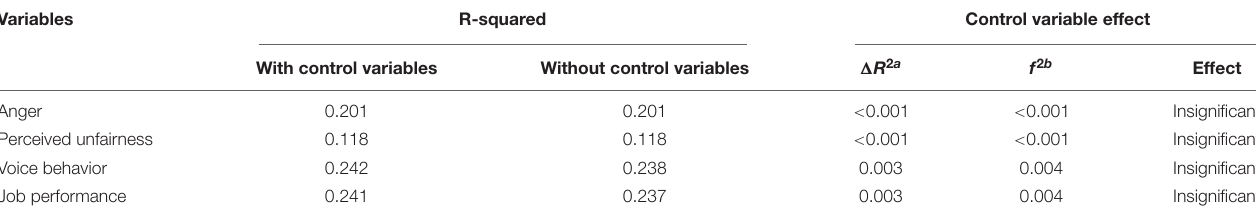
TABLE 4 | Results of multivariate coefficient of determination ( R 2 ).